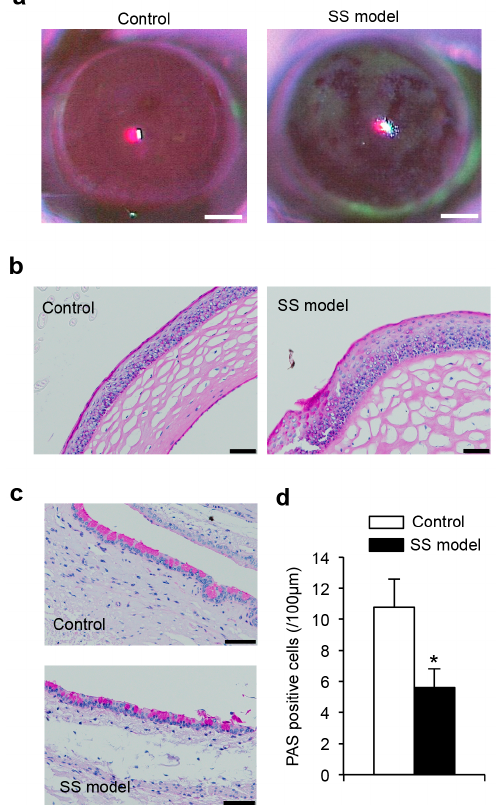
Figure 2. Keratoconjunctivitis of the SS model mice. ( a ) One to two μ L of fluorescein solution was applied to the cornea by micropipette. The residual liquids around the eye were washed with saline and gently wiped off using filter paper. Corneas were examined for epithelial disorders using a slit-lamp microscope with a blue filter. The results are representative of five mice in each group. Scale bar: 1 mm; ( b ) Histological findings of corneal epithelia. Sections of corneal tissues of the control and the SS model mice were stained with (periodic acid-Schiff) PAS. Photos are representative of five mice for each group. Scale bar: 50 µ m; ( c ) PAS + mucin-producing goblet cells in conjunctival tissues of control and SS model mice are shown. Photos are representative of five mice in each group. Scale bar: 50 µ m; and ( d ) The number of PAS + mucin-producing goblet cells in conjunctival tissues of control and SS model mice is shown. The data are means ± SD of five mice in each group. * p < 0.05.